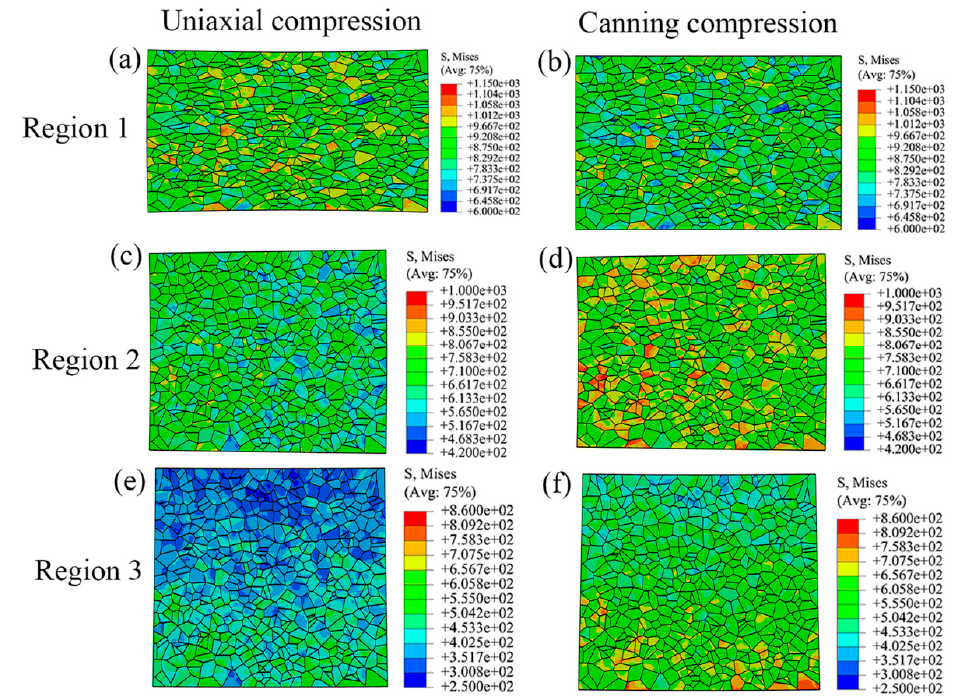
Figure 6. Stress distribution at the microscale level during uniaxial compression and canning compression processes with the locations of the polycrystalline models corresponding to regions 1, 2, and 3 in Figure 4.